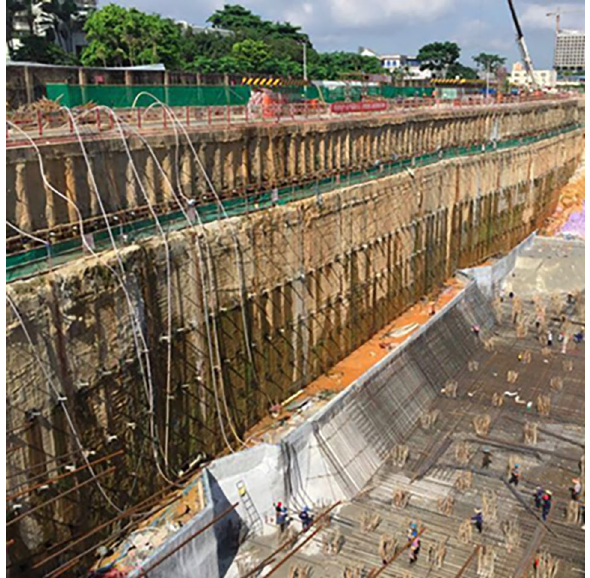
Figure 4. Construction photo of the composite retaining and protection structure at the south side of the